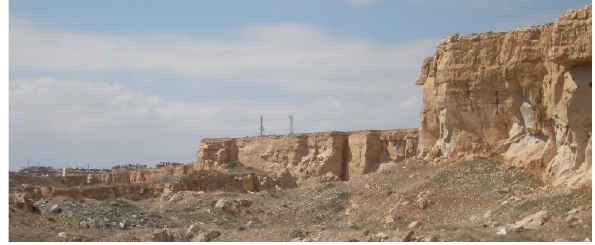
Figure 2. An image from the quarry